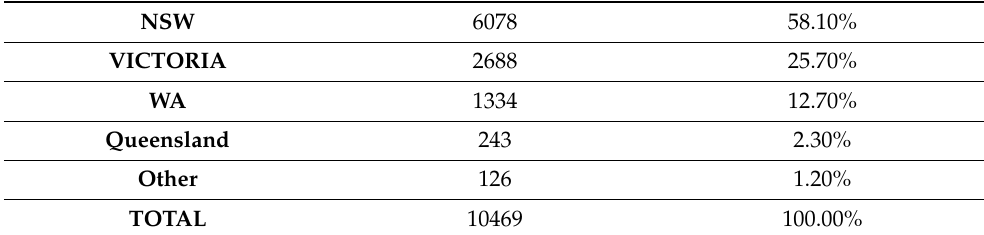
Table 1. “JA Survey”, Rutland and Gariano